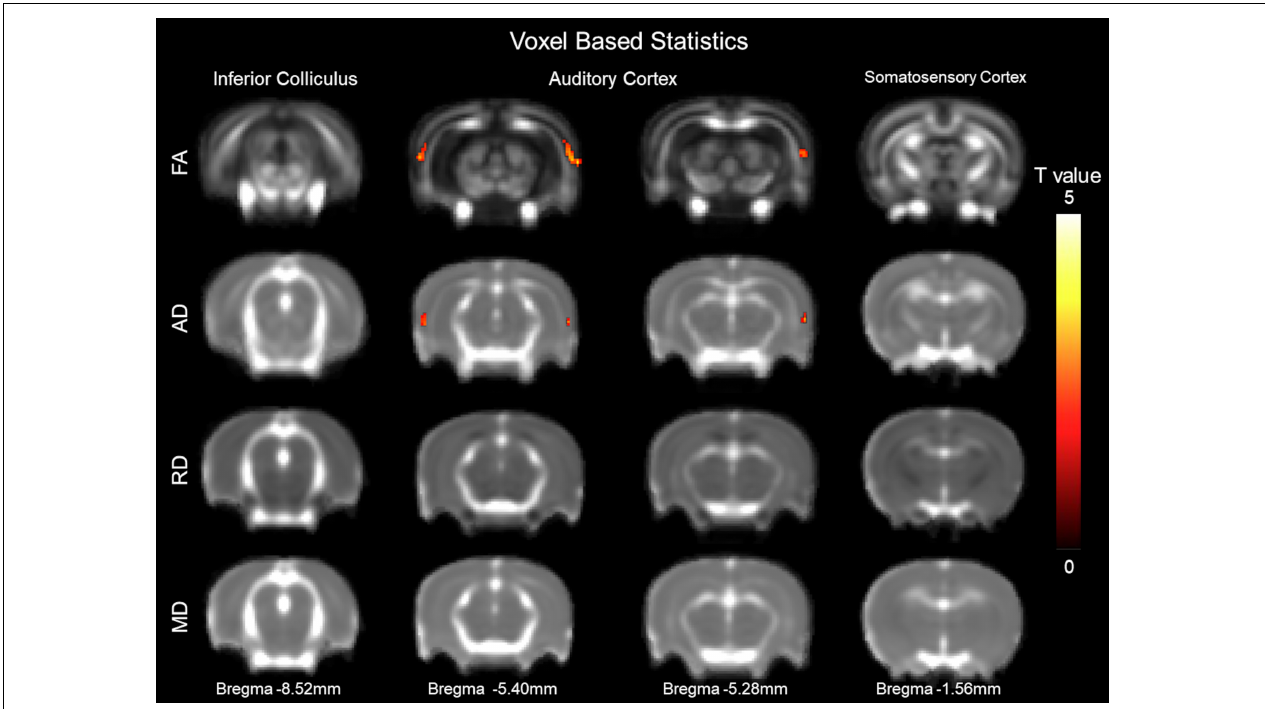
FIGURE 2 | Structural alterations underlying conductive hearing loss assessed by DTI voxel-based statistics. The y-axis representing rows are fractional anisotropy (FA), axial diffusivity (AD, λ //), radial diffusivity (RD, λ ⊥ ), and mean diffusivity (MD). Columns represent different Bregma locations –8.6, –6.40, –5.3, and –2.0 mm. Color bars represent positive t value differences between before and after CHL (warm colors from 0 to 5). The maximum point of significance for FA was t = 3.170, and for AD was t =